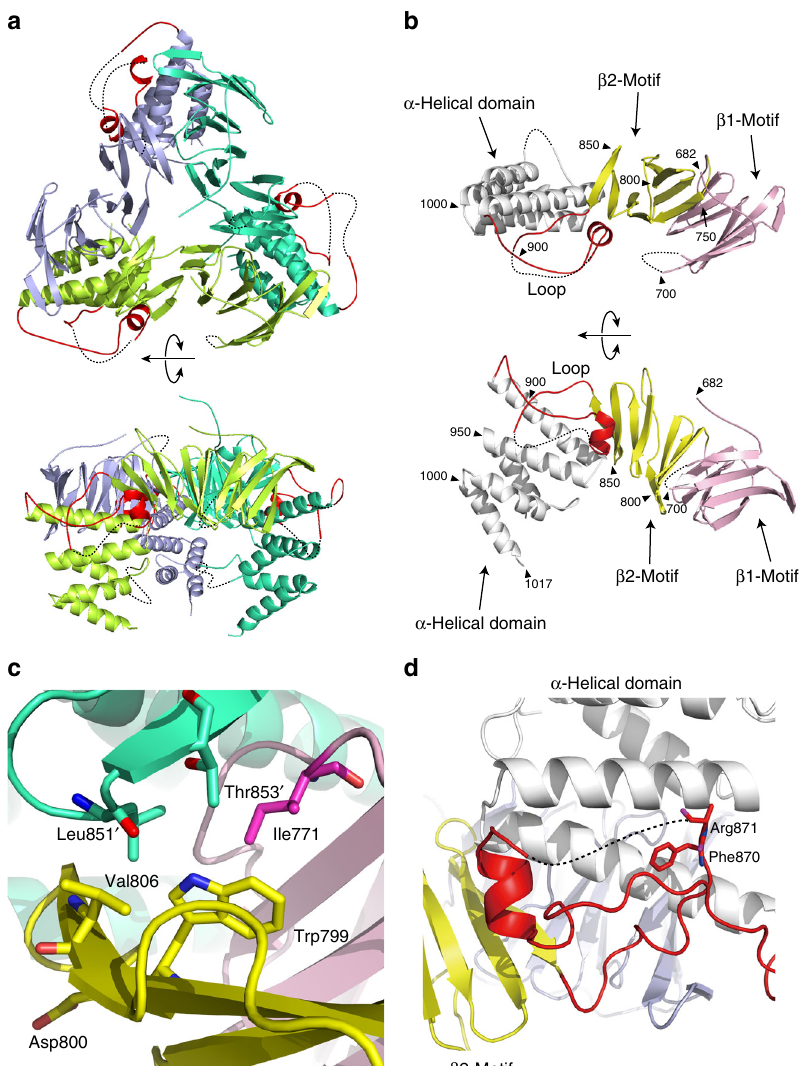
Fig. 4 Crystal structure of HIRA(644 – 1017) reveals a homotrimer. a Overall structure of homotrimeric HIRA(644 – 1017). Subunits A, B and C are shown in light green, emerald green, and blue, respectively. The loop regions (860 – 907) are shown in red. b Structure of the HIRA monomer. The β 1 and β 2 motifs are shown in pink and yellow, respectively. The α -helical domain and the loop region are shown in white and red, respectively. Black triangles indicate residue numbers of HIRA(644 – 1017). c Trp799 located at the interface between subunits A and B (emerald green). d The CABIN1-binding loop shown in red and highlighting Phe870 and Arg871. The side chain of Arg871 was not visible in the crystal structure. Residues in the α -helical domain are